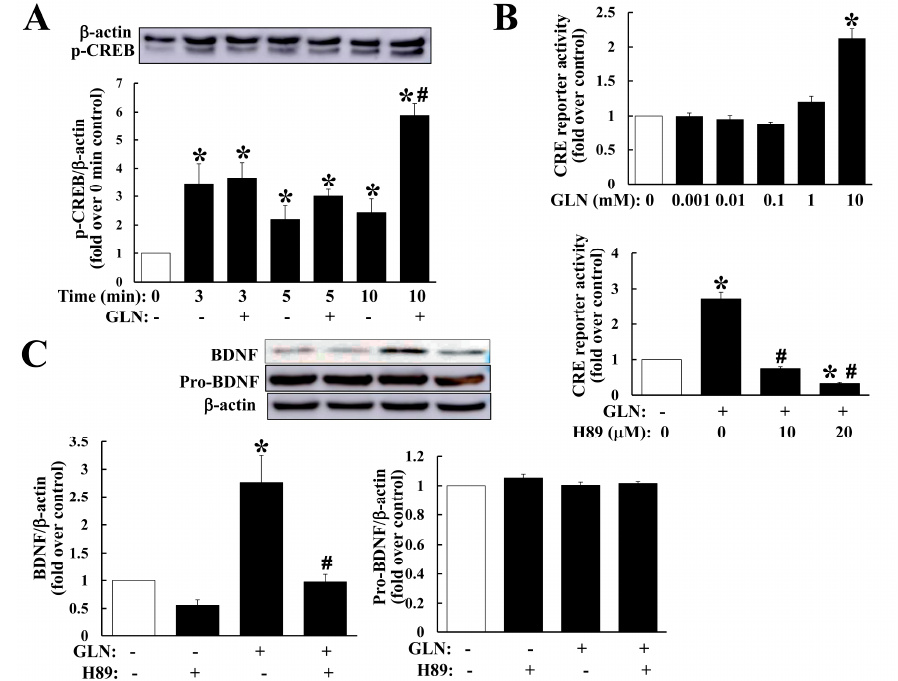
Figure 4. GLN impact on the cAMP/PKA signaling in relation to BDNF production in HT22 cells. HT22 cells were exposed to GLN (10 mM) for indicated times and the CREB phosphorylation manner was analyzed with Western blotting normalized by the β -actin ( A ). To examine the GLN effect on the CRE reporter activity, HT22 cells were cotransfected with a CRE reporter plasmid and a p -CMV- β -gal control plasmid, followed by the treatment with GLN (10 mM) alone or in combination with H89 (10 and 20 µM) for 24 h. The luciferase activity in cell lysates was analyzed and normalized against the β -gal activity within the same sample ( B ). To reveal the significance of the GLN-induced cAMP/PKA signaling in BDNF expression, HT22 cells were treated with GLN (10 mM) alone or in combination with H89 (20 µM) for 24 h and BDNF expression was determined ( C ). The results represent the means ± S.D. ( n = 3–4). *, p < 0.05 compared with the 0 mM group ( A , B , C ); #, p < 0.05 compared with the control group within the same time point ( A ) or with the GLN alone group ( B , C ).